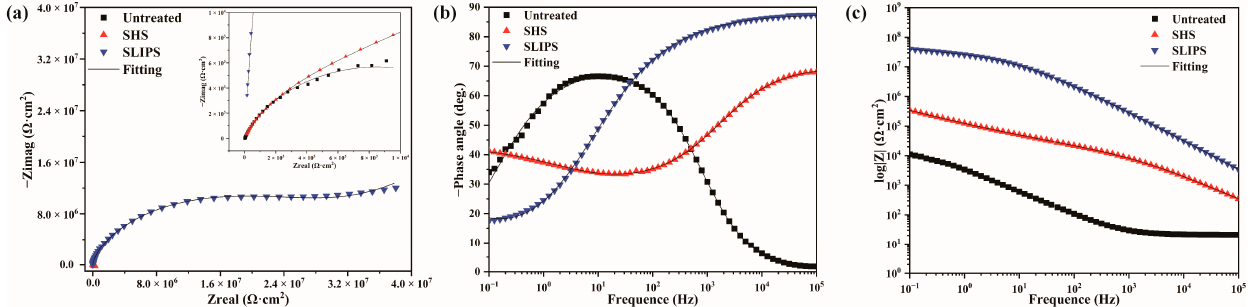
Figure 6. EIS after immersion in simulated seawater for 1 h: ( a ) Nyquist plots; Bode plots of ( b ) phase angle vs. Frequency; and ( c ) | Z | vs. Frequency for the three samples.